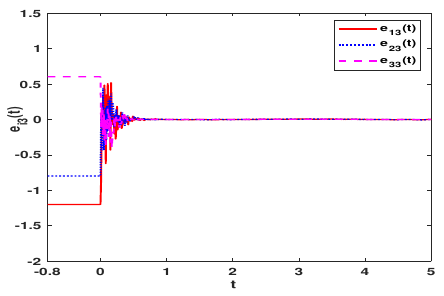
Figure 6. The synchronization errors e i 3 ( t ) . The adaptive laws ϑ i 1 ( t ) , ϑ i 2 ( t ) and ϑ i 3 ( t ) are demonstrated in Figures 7–9. The adaptive laws finally tend to be constants, which indicates that the FATSMC achieves the paper is feasible.